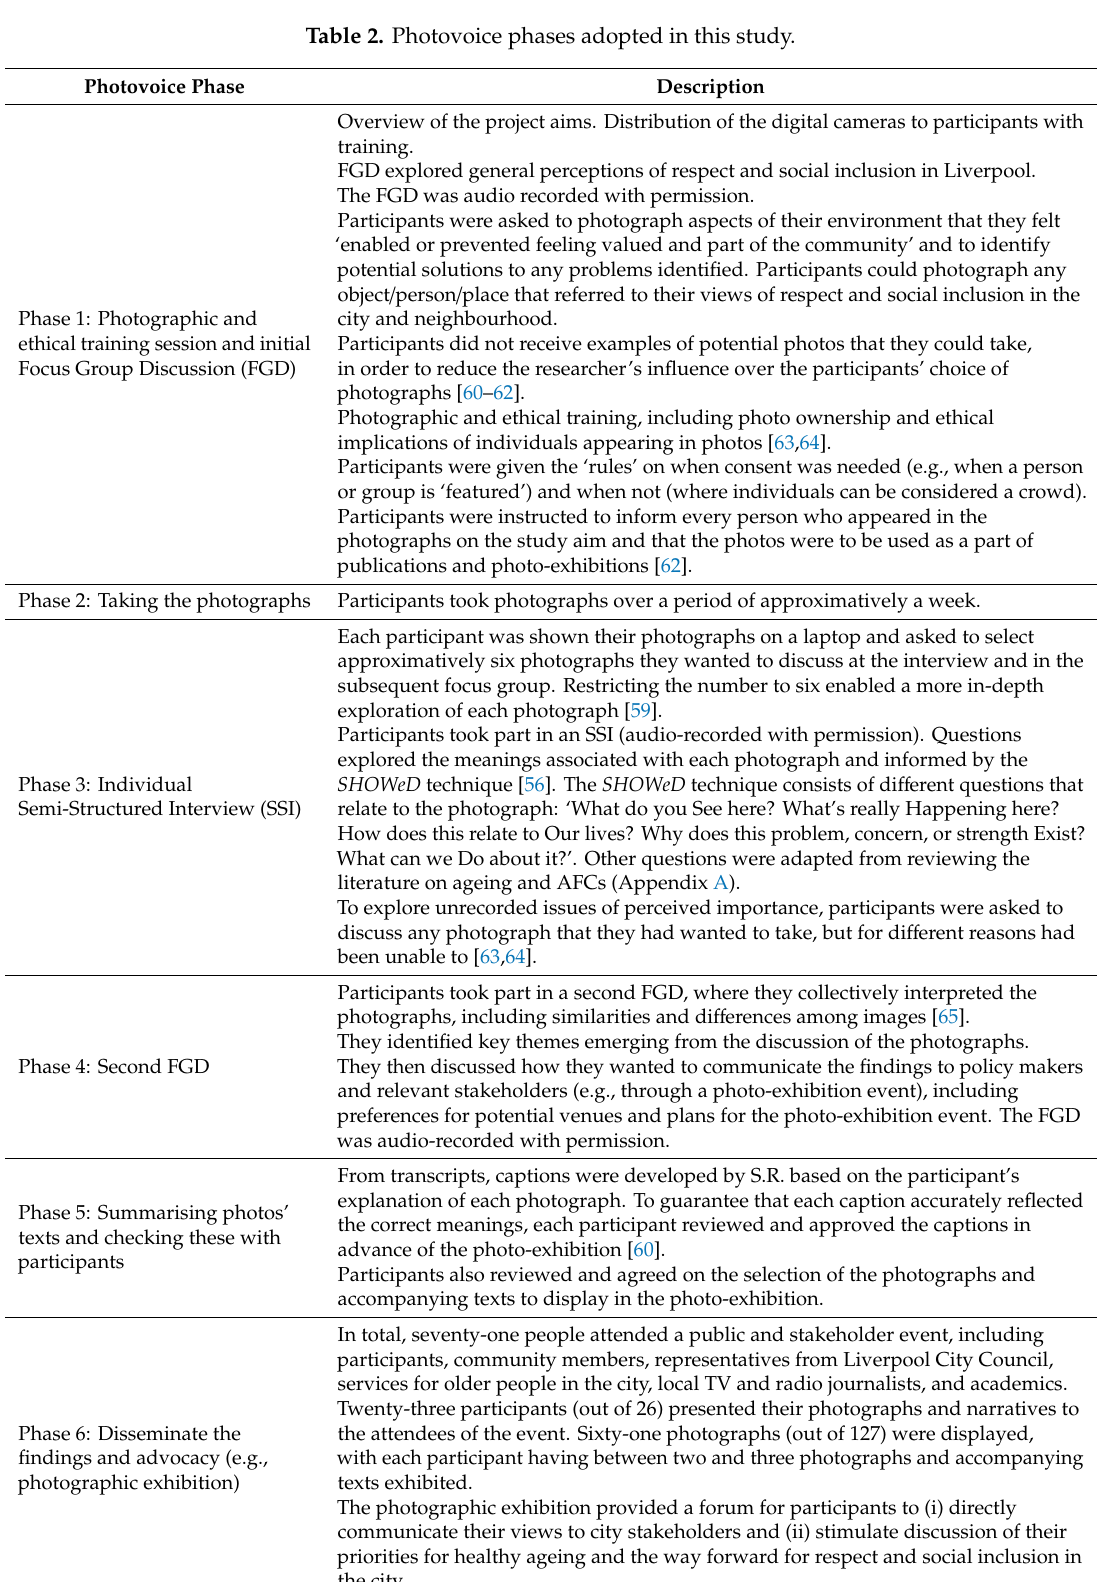
Table 2. Photovoice phases adopted in this